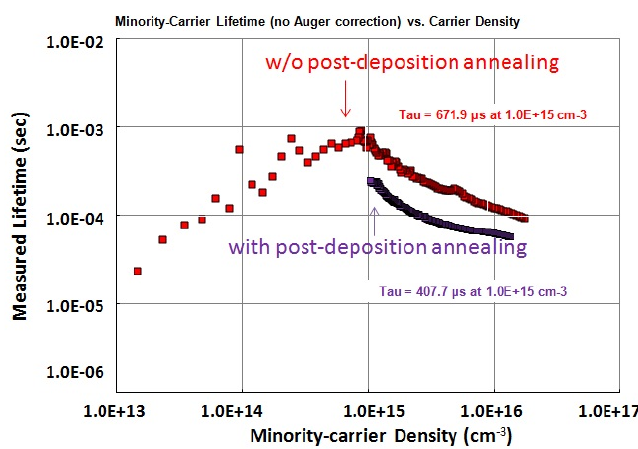
Figure 7. Minority carrier lifetime as function of carrier density for two TiO 2 films: One is deposited for 250 cycles without post-deposition annealing, and another is deposited for 250 cycles with post-deposition annealing at 200 °C for more 6000 seconds in the chamber.